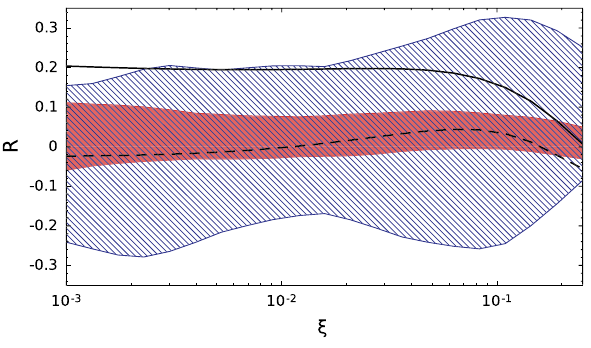
Fig. 5 Ratio R defined in Eq. (19) evaluated with LO and NLO spacelike-to-timelike relations for Q (cid:4) 2 = 4 GeV 2 , t = − 0 . 35 GeV 2 as a function of ξ . For the further description see the caption of Fig.